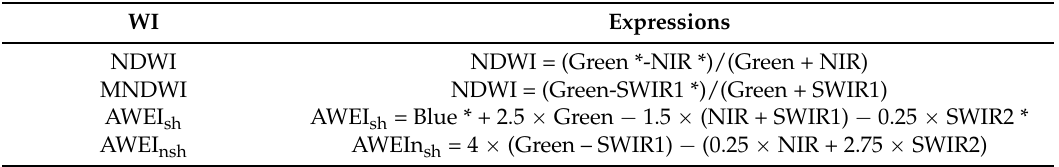
Table 1. Mathematical formulations of four common